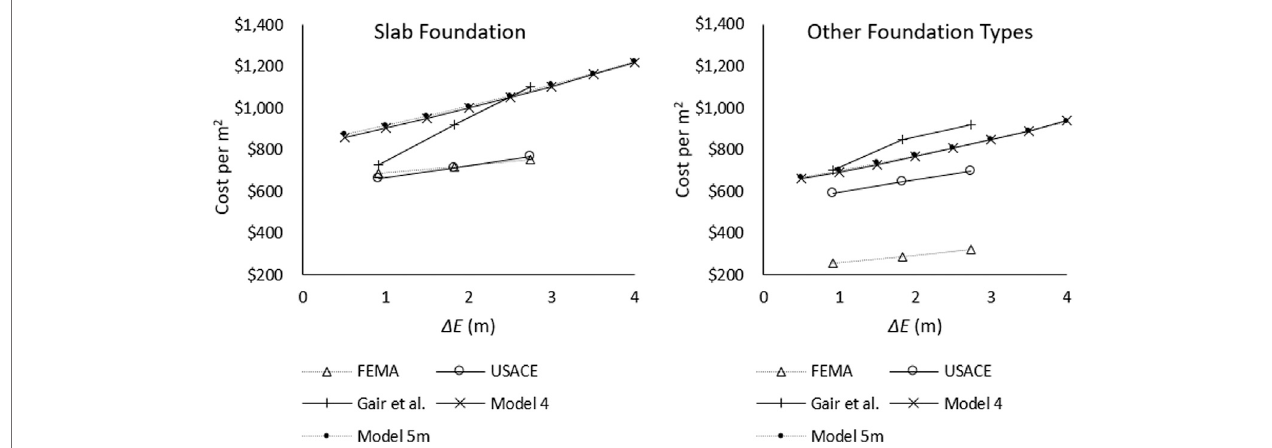
FIGURE 7 | Average cost/m 2 to elevate a one-story home with slab foundation (left) and other foundation types (right) .